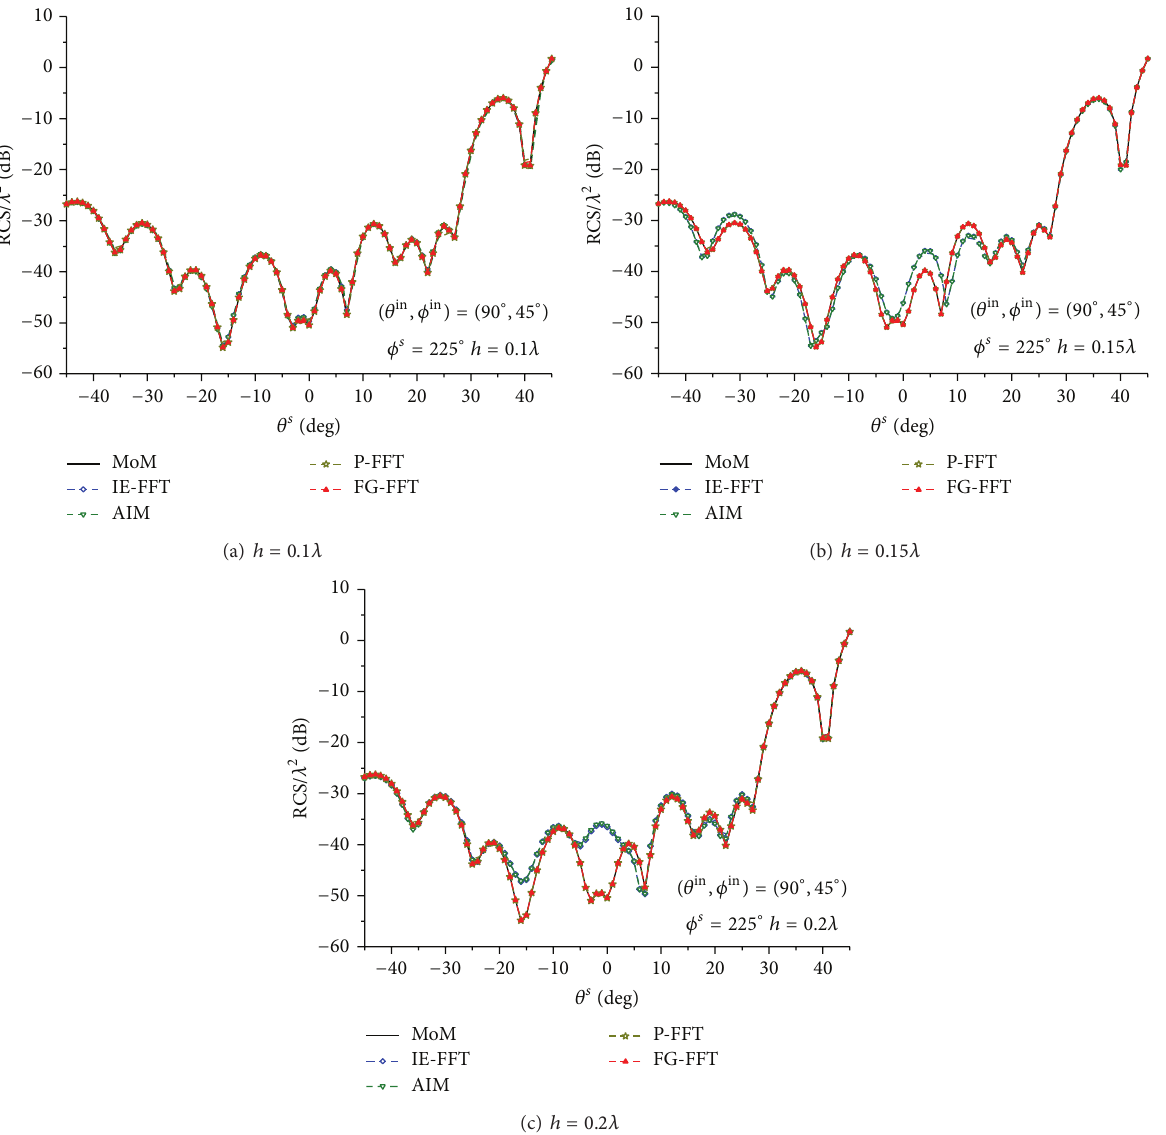
Figure 6: Bistatic RCS curves of the homogeneous dielectric slab in Example B.